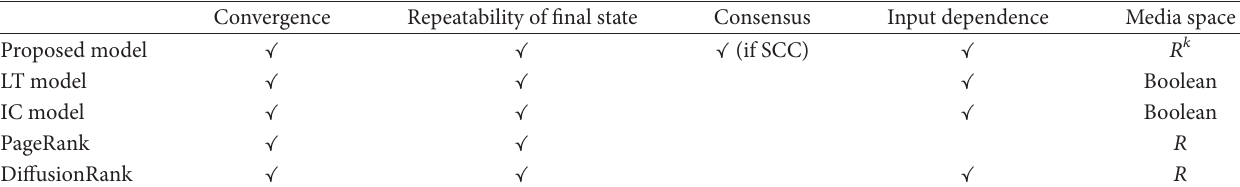
Table 1: Comparison of models on the abilities to capture characteristics of real world social networks